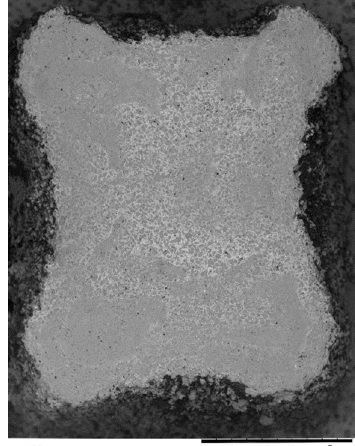
Figure 15. Top cross-section surface morphology of sample made with optimal processing parameters.